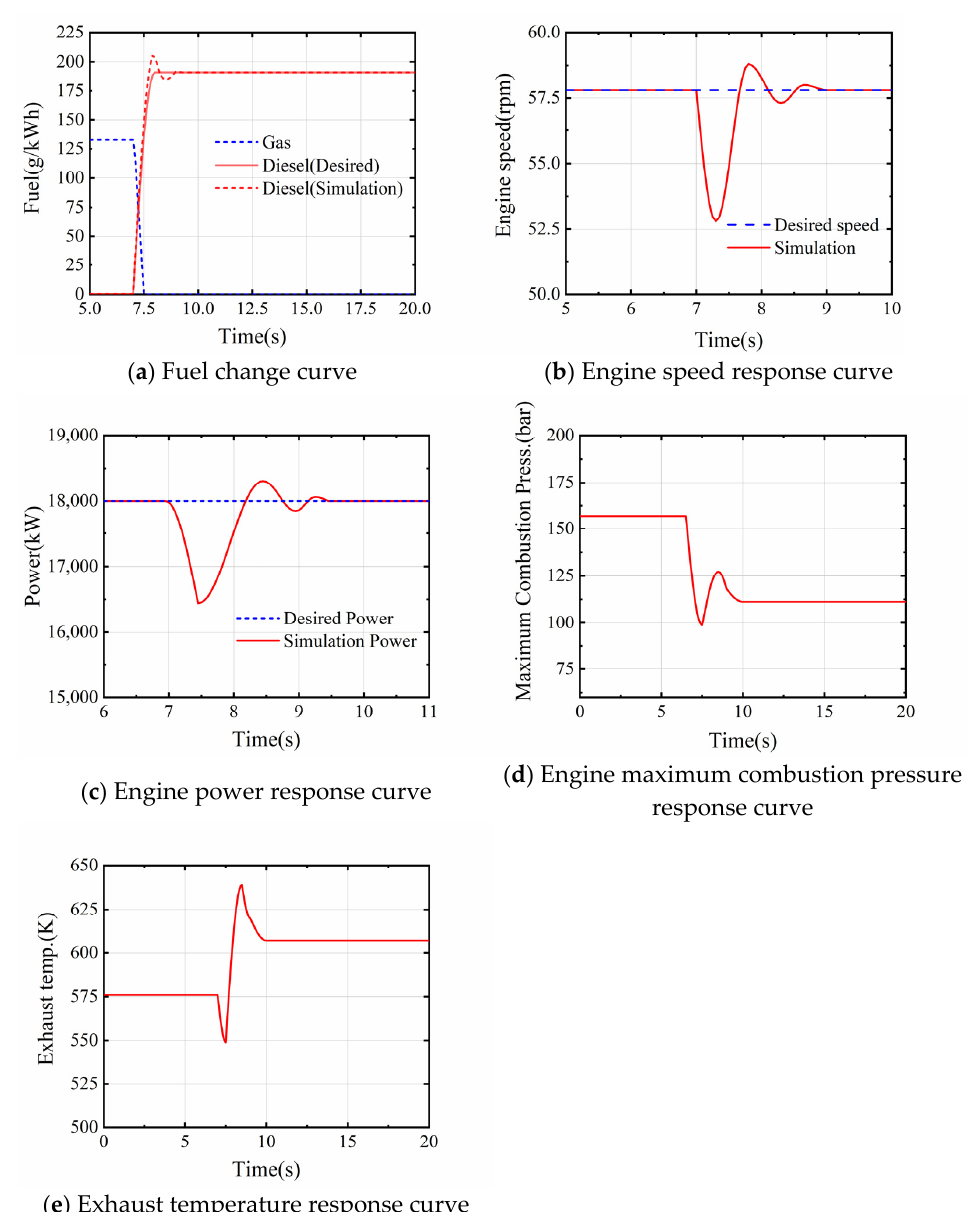
Figure 7. The response curve of engine performance parameter.